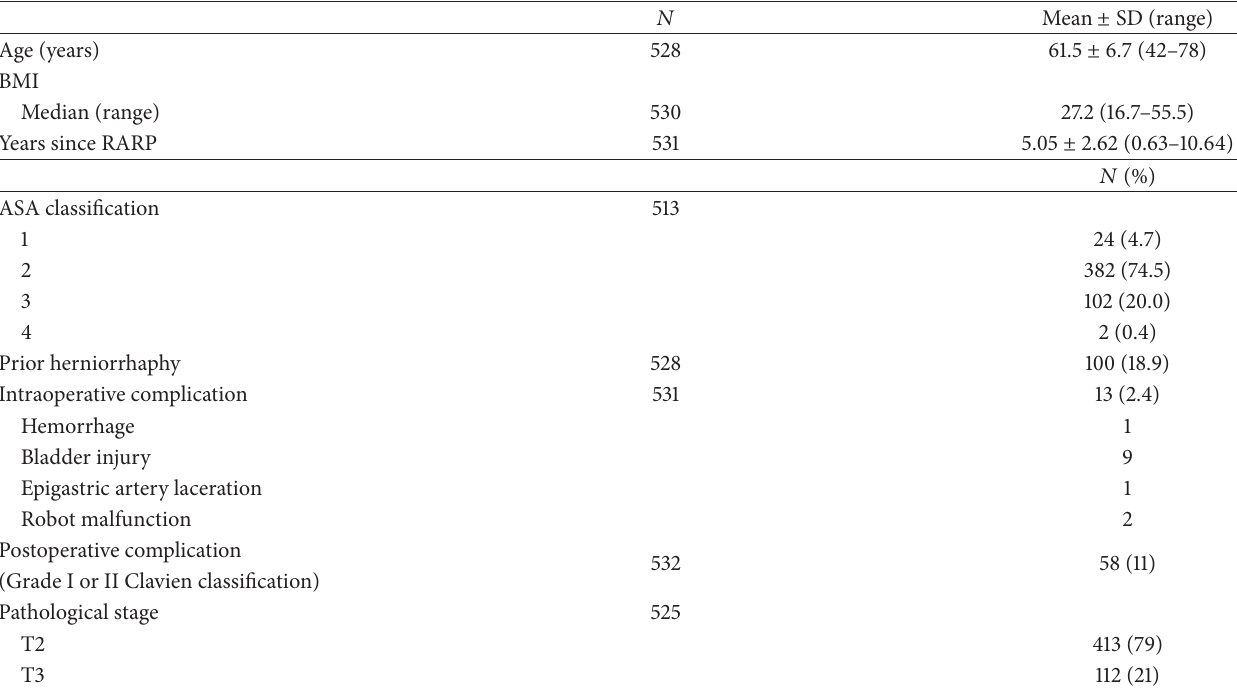
Table 1: Patient characteristics and surgical data for 532 patients with no hernia or incisional hernia.